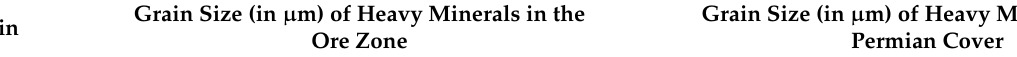
Figure 8. TIMA SEM mineral map of gold- and sulfide-containing particles in the mineralization. Gold and galena occur as small inclusions (black squares in the bottom-left pyrite grains) in pyrite. Pentlandite is associated mainly with pyrrhotite. Table 1. Statistical analysis (minimum, maximum, average, and standard deviation) of the grain size of gold and individual sulfide mineral in the ore zone and the base of the Permian cover. A total of 33 samples were collected from the Permian cover and 3 samples from the ore zone. The column “Nr. samples” indicates how many of these samples contain grains of a particular mineral. The column “Nr. grains” indicates how many grains of a particular mineral in these samples. Chacocite, covellite and bornite is not identified in the ore zones and given the symbol